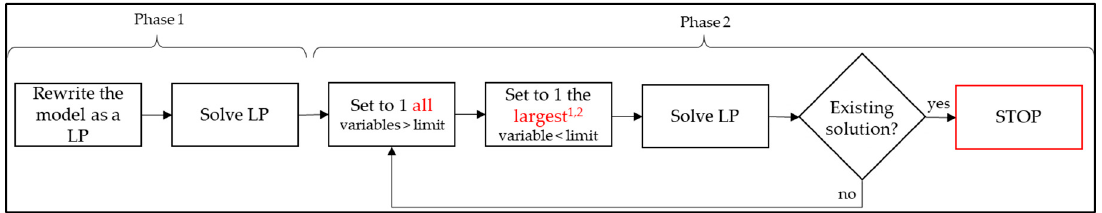
Figure 4. The linear relaxation-based heuristic. In the first phase, the algorithm rewrites the model as LP and solves it. In phase two, the code fixes the model to indicate after the iterations an integer and possible solution to the problem. (the largest variable without a product designated to stockpile the variable has to be higher than 0).